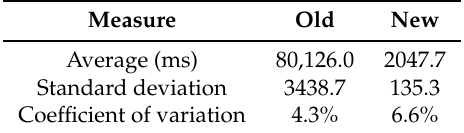
Table 5. Coefficient of variation for the Fuzzy Beer 500 ontology.